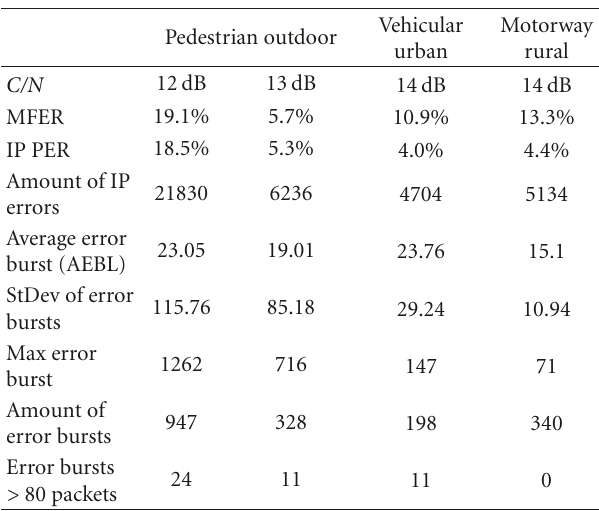
Table 3: IP error statistics for three di ff erent channels measured over 60 seconds.